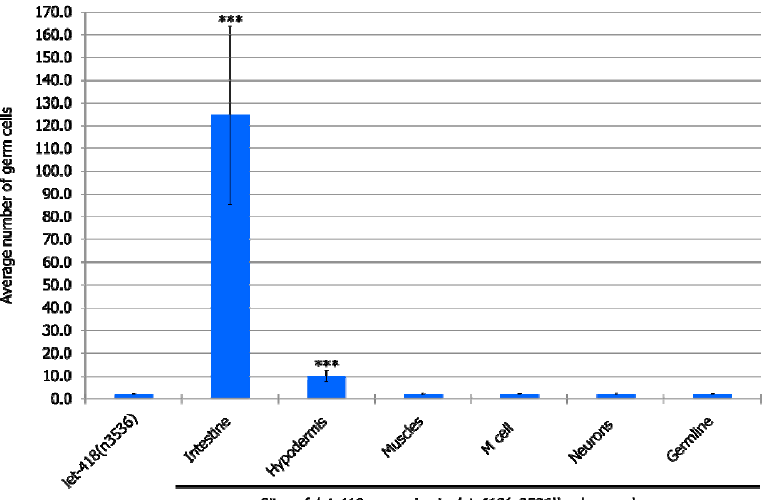
Figure 4. LET-418 activity is required in the intestine and the hypodermis for germ cell proliferation. The highest average number of germ cells is plotted for the indicated genetic backgrounds. For clarity purposes wild worms, which show an average of 1024 ± 24.2 germ cells at 124 h after birth is not represented on this graph. Error bars indicate standard deviation. *** p < 0.001; unpaired t -test against let-418(n3536)